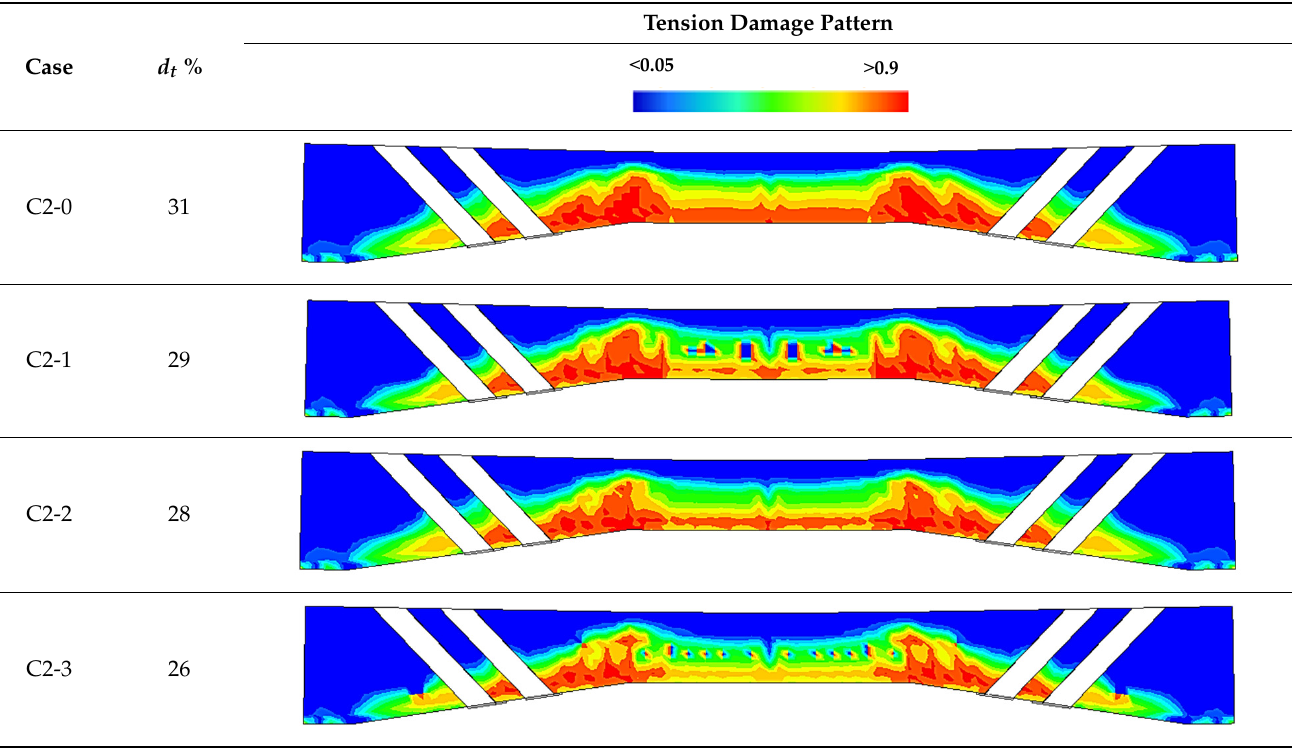
Table 3. Damage representation for C2 model.